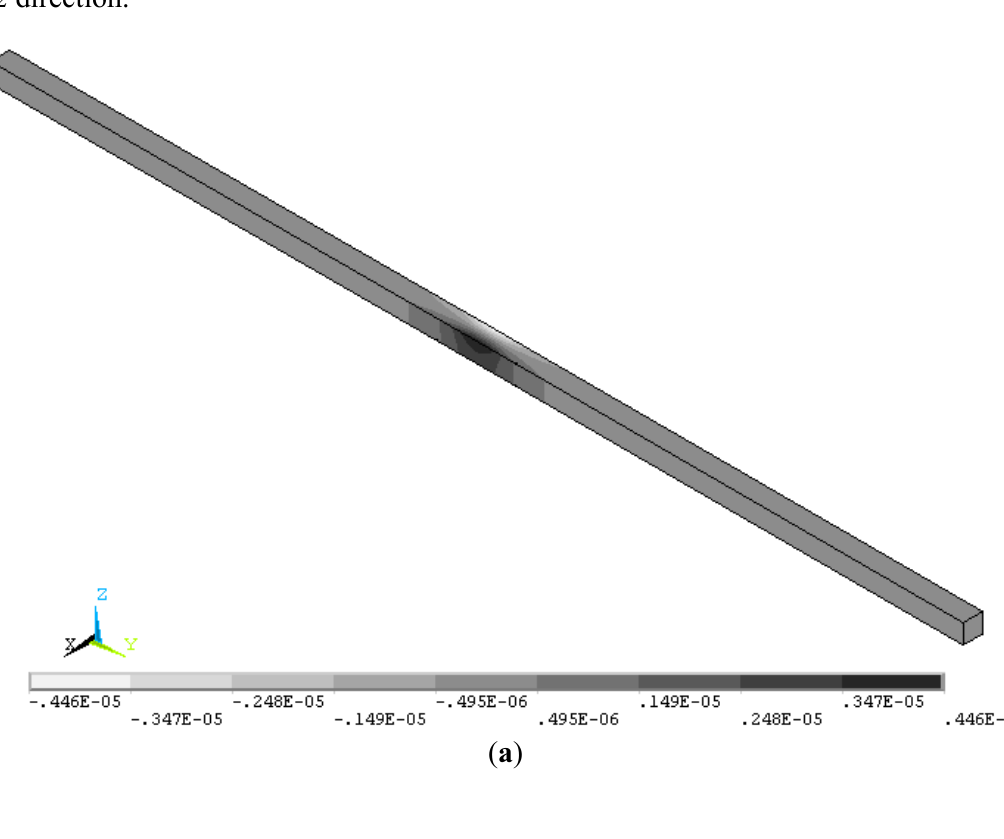
Figure 5. Displacement distribution at t = 1 s: ( a ) x direction; ( b ) y direction; and ( c ) z